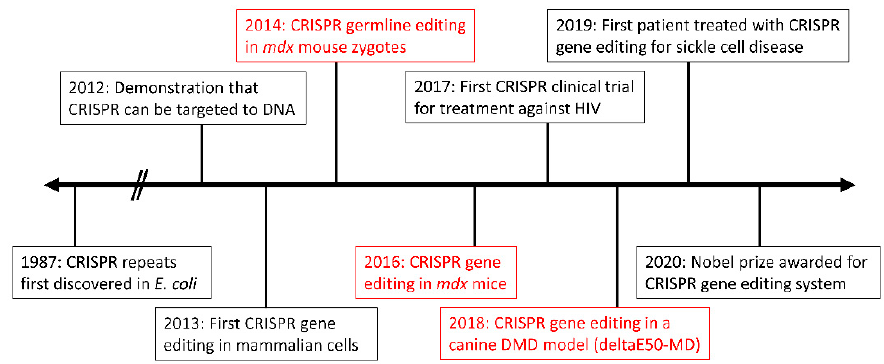
Figure 2. Timeline highlighting the major milestones in CRISPR gene editing for human diseases. Achievements in the field of DMD research are in red.